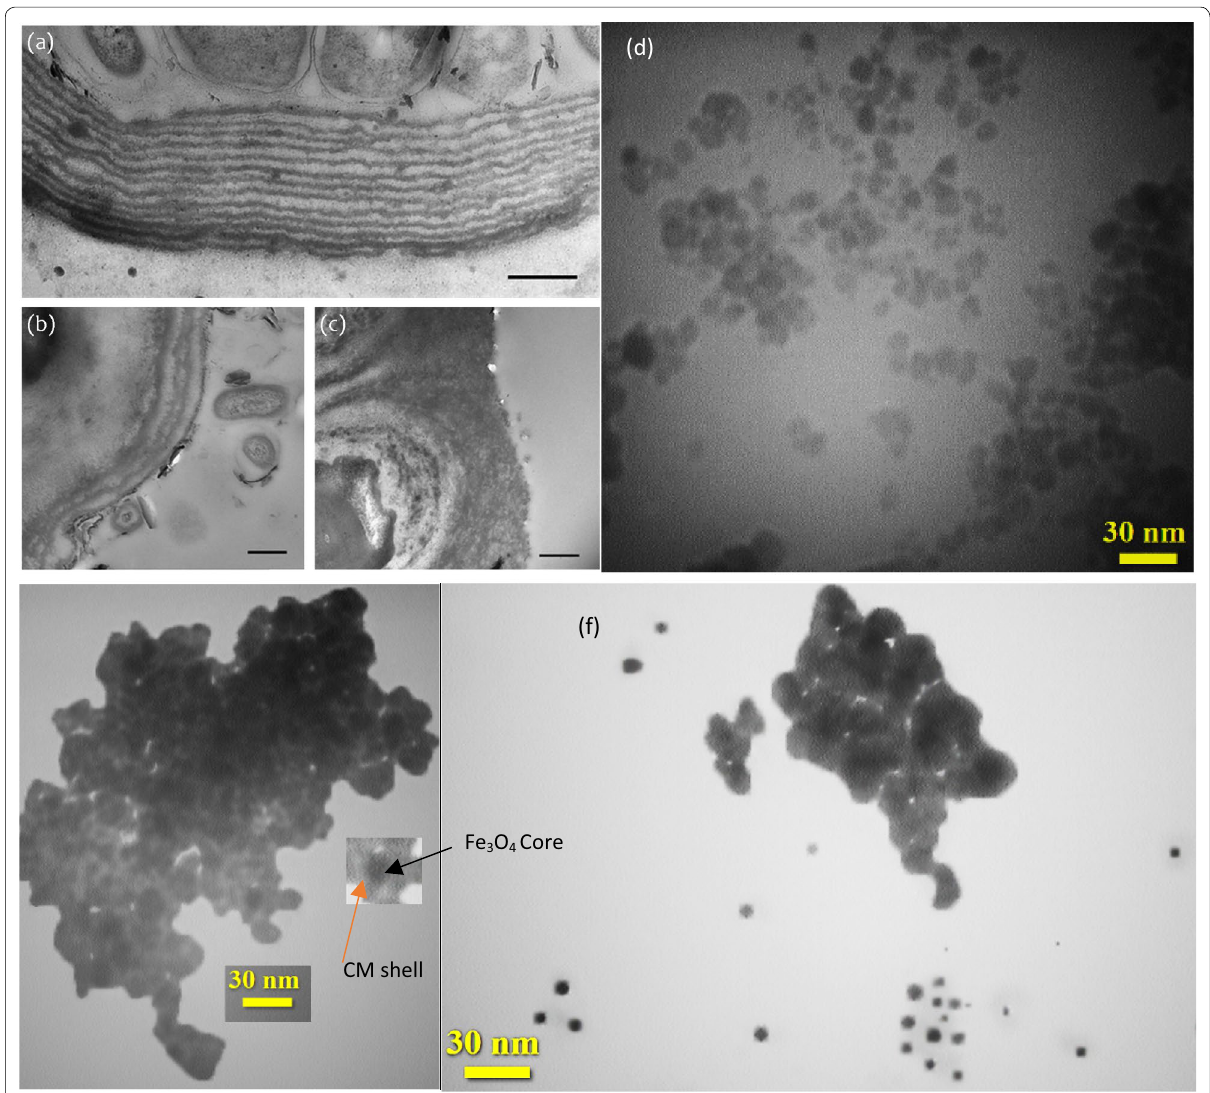
Fig. 4 TEM micrographs showing the cuticle of a Chondrus crispus frond at sections from a tip, b middle and c base (Reprint by permission from www.natur e.com/scien tific repor ts https ://doi.org/10.1038/srep1 1645) and d – f Fe 3 O 4 @CM with 30 nm